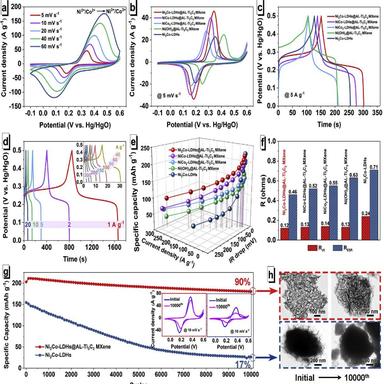
(a) CV curves of the Ni2Co-LDHs@AL-Ti3C2 MXene electrode at different scan rates. (b) CV curves of the Ni2Co-LDHs@AL-Ti3C2 MXene and its counterparts at a scan rate of 5 mV s1 . (c) GCD curves of the Ni2Co-LDHs@AL-Ti3C2 MXene and its counterparts at a current density of 5 A g1 . (d) GCD curves of the Ni2Co-LDHs@AL-Ti3C2 MXene electrode at different current densities. (e) Relationship of specific capacitance, current density and IR drop of the Ni2Co-LDHs@AL-Ti3C2 MXene and its counterparts. (f) Comparison of